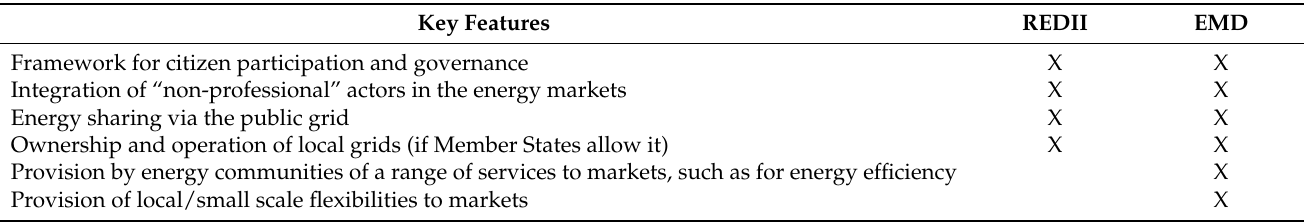
Table 2. Features of high relevance for PEBs/PEDs enabled through provisions of the CEP. Key